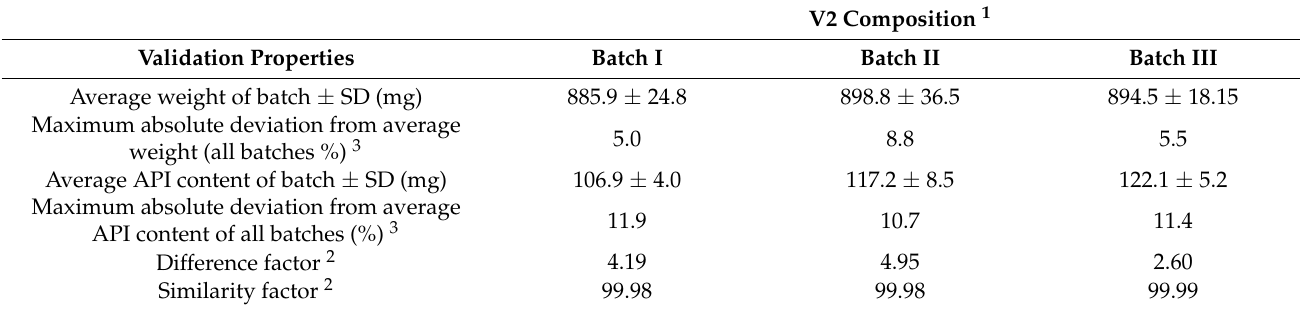
Table 4. Validation properties of V2 compositions. Three batches were produced at different times.